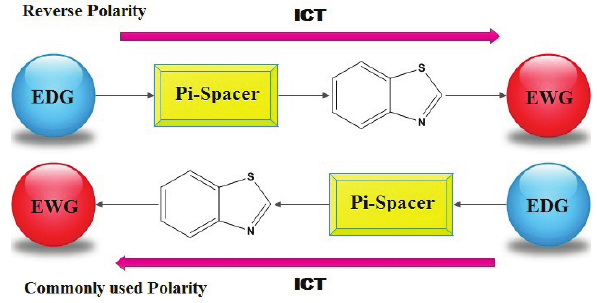
Figure 1: Matched and mismatched alignment of the benzothiazole (BT) with respect to electron-donating (EDG) and electron- withdrawing (EWG)